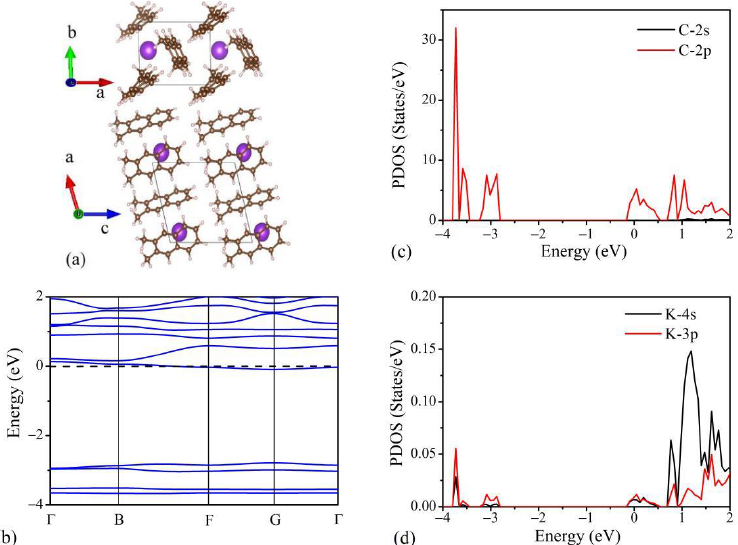
Figure 5. ( a ) The theoretical potassium-doped 2,3-DMN crystal structure in a 2 × 1 × 1 supercell. The brown and purple balls represent C and K atoms, respectively. ( b ) The band structure of theo- retical potassium-doped 2,3-DMN. ( c , d ) Partial density of states (PDOS) of theoretical potassium-doped 2,3-DMN. ( c) PDOS of C 2s (black lines) and C 2p (red lines) orbitals, ( d ) PDOS of K 3p (red lines) and K 4s (black lines) orbitals, respectively.